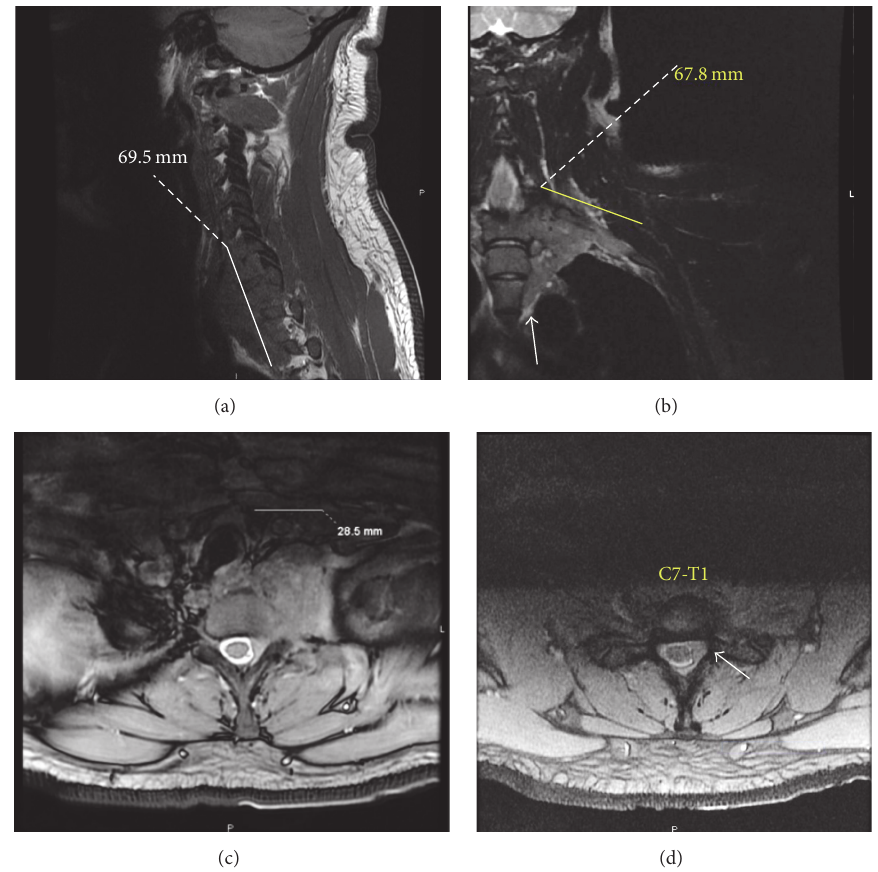
Figure 2: Magnetic Resonance Imaging (MRI) of the cervical spine and brachial plexus at cervical-thoracic levels: T2-weighted images with left paraspinal soft tissue mass and brachial plexus infiltration in sagittal (a), coronal (b), and axial (c) views and intraspinal extension (d).